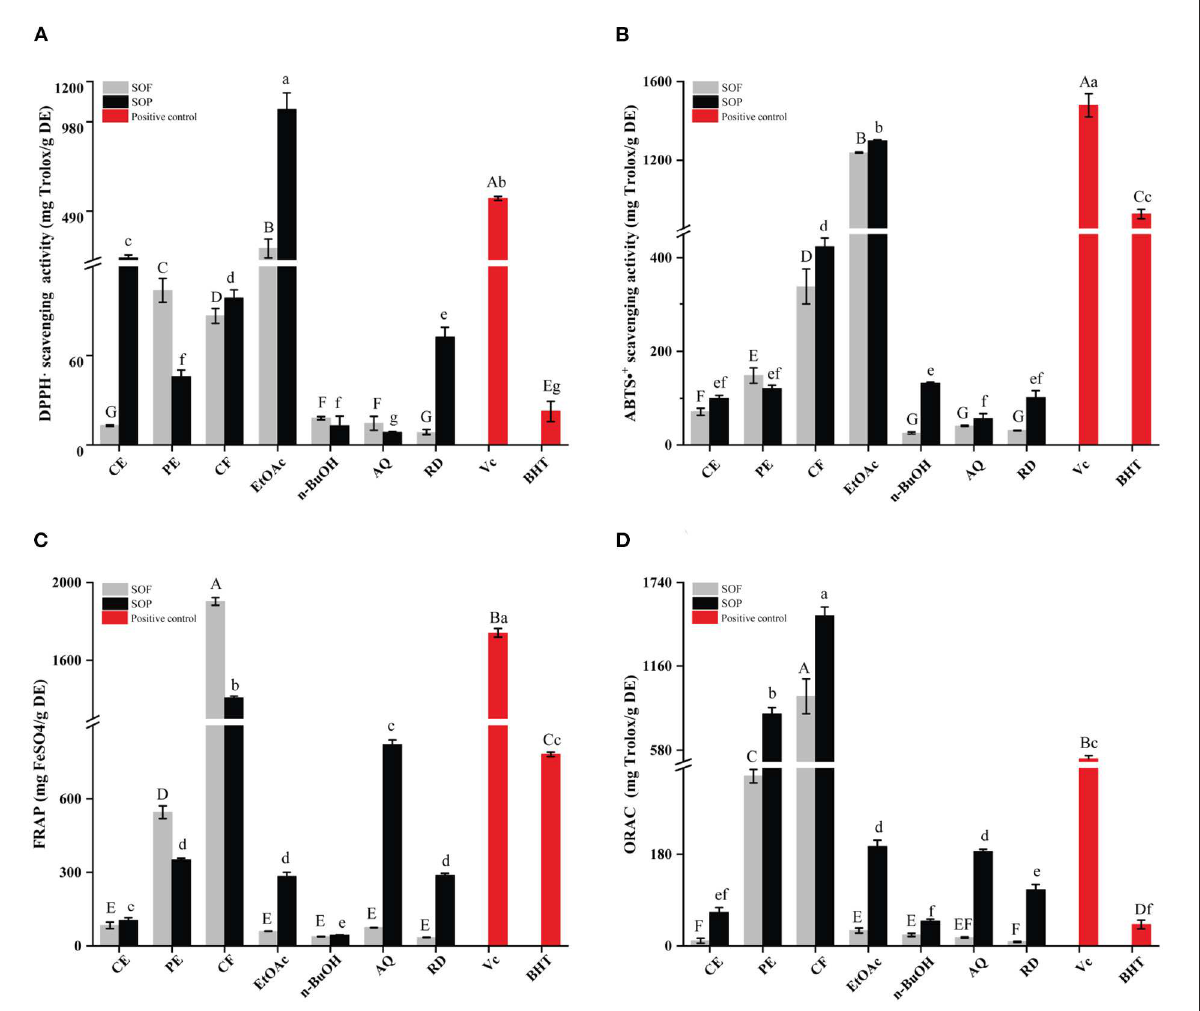
FIGURE1 The antioxidant activities of the SOEs and its fractions. (A) DPPH · scavenging activity (DPPH), (B) ABTS · + scavenging ability (ABTS), (C) Ferric reducing antioxidant power (FRAP), (D) Oxygen radical absorbance capacity (ORAC). SOEs, Stauntonia obovatifoliola extracts; SOF, Stauntonia obovatifoliola flesh; SOP, Stauntonia obovatifoliola pericarp. CE, crude extract; PE, Petroleum ether fraction; CF, chloroform fraction; EtOAc, ethyl acetate fraction; n-BuOH, n-Butanol fraction; AQ, aqueous phase residue; RD, residue. The superscript letters indicate the statistical difference in rows in significant, p <